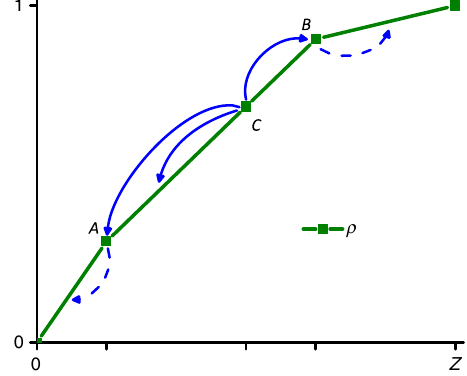
FIG. 8. Action of partial isothermal reversible processes.